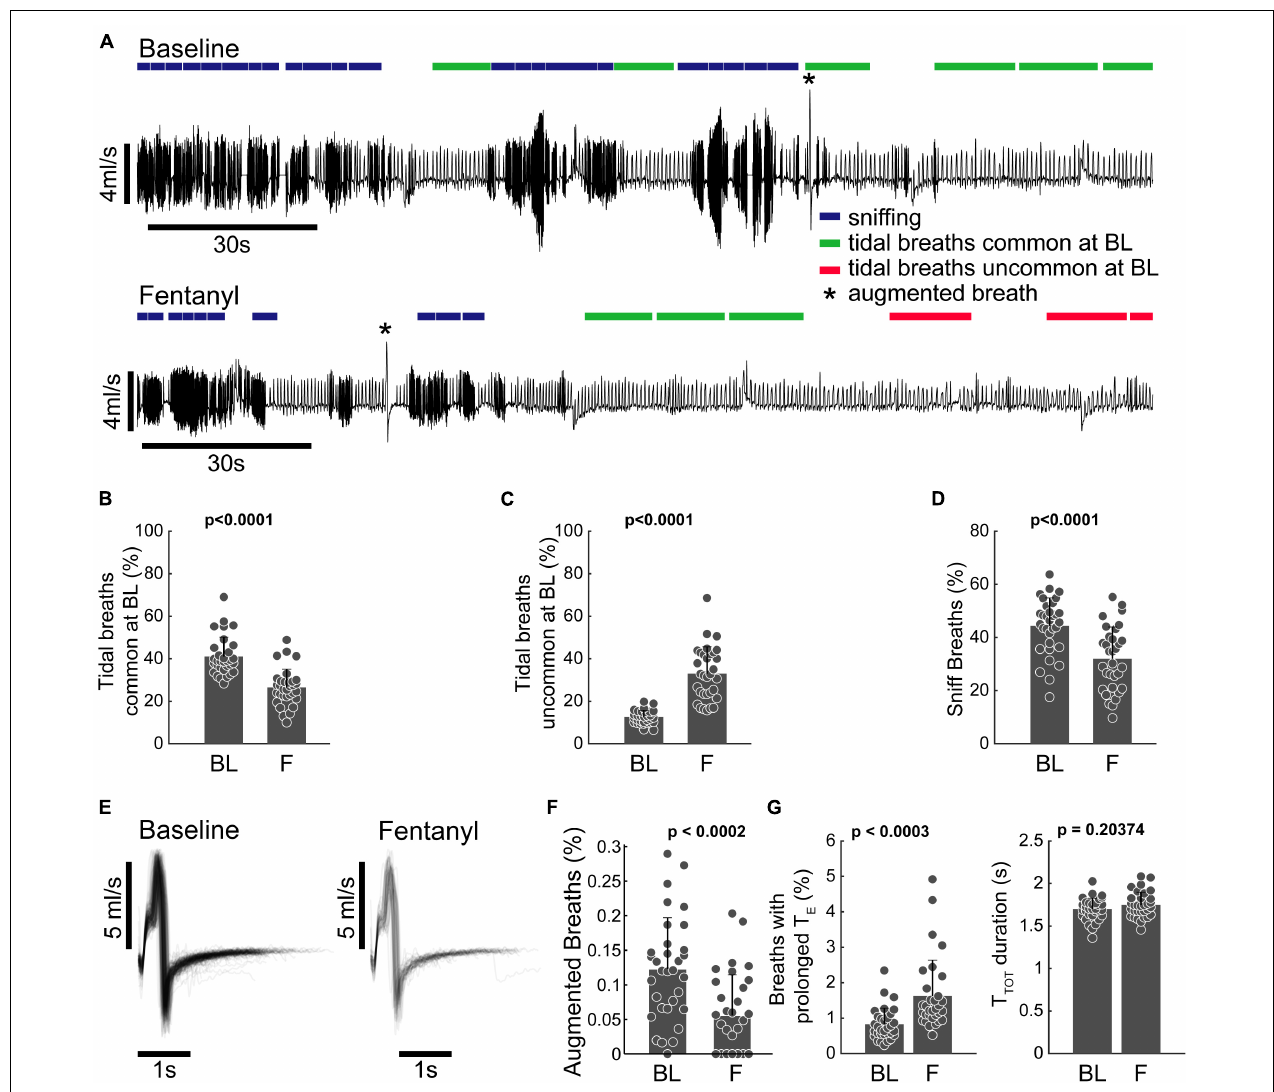
FIGURE 3 | Clustering allows for behavioral annotation and quantification. (A) Example plethysmography traces from the baseline and fentanyl periods of the same animal. 20-breath bins are annotated to indicate sniffing (blue), common tidal breathing (green), uncommon tidal breathing (red), and augmented breaths (*cluster 19). Epochs were only marked if the majority of breaths met the inclusion criteria (the majority of waveforms belonging to a specific set of clusters, see text). (B,C) Percentage of breaths belonging to clusters 5–15 that represent breaths that have lengths associated with tidal breathing. (B) Breaths that had waveforms common at BL (clusters 5, 6, 11, 12, and 14) decreased following fentanyl infusion and (C) breaths with waveforms uncommon at baseline increased during fentanyl infusion. (D) Percentage of breaths belonging to clusters 1–3 (sniffing behavior) during the baseline and fentanyl periods. (E) Pile plot of all breaths classified as belonging to cluster 19 during baseline and fentanyl infusion. (F) Percentage of breaths during baseline (BL) and fentanyl infusion (F) which were classified as cluster 19. Cluster 19 breaths were completely absent during the last 3rd of the fentanyl infusion period (i.e., by the time the rat’s minute ventilation dropped to 50% of baseline there were no augmented breaths). (G) Prevalence, and duration (T TOT ) of breaths with prolonged expiratory duration (T E ), but not the characteristic shape of an augmented breath; during the baseline (BL) and fentanyl (F) periods. n = 32 animals (all animals in study pooled together). All comparisons were made using a paired sample two-tailed t -test.